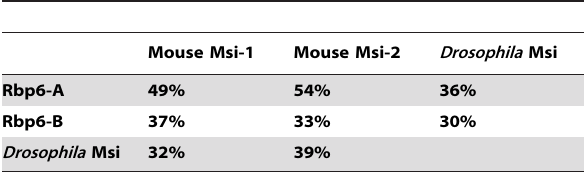
Table 2. Percentage amino acid identity between Mouse and Drosophila Musashi family